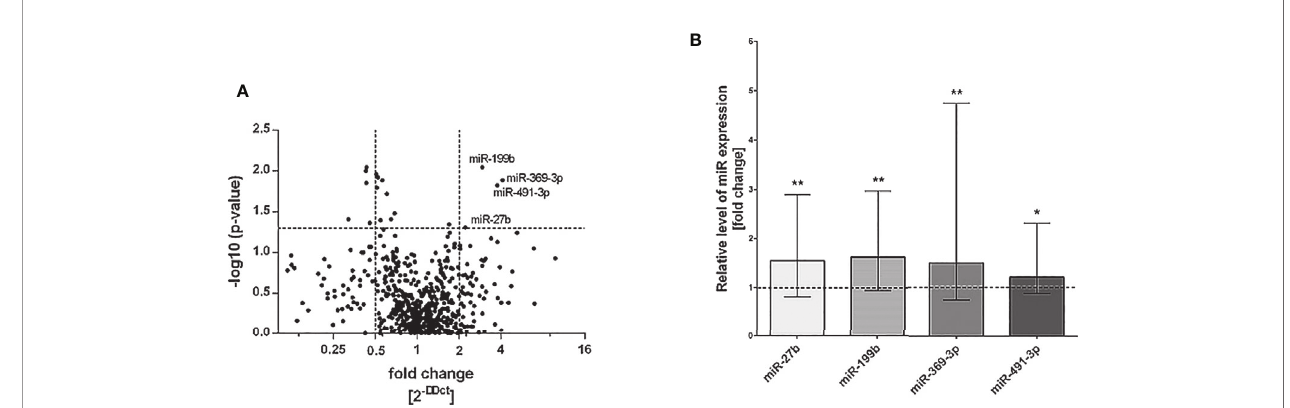
FIGURE 1 | miRNA real-time PCR analysis. Volcano plot showing differential miRNA expression levels in patients with HSV infection in comparison to control group. The vertical lines correspond to 2-fold up and down change and the horizontal line represents a P value of 0,05 (A) . Expression of miRNAs miR-27b, miR-199b, miR-369-3p and miR-491-3p presented as fold change of each miR relative expression normalized to U6 expression and healthy control group (2 − DD CT ). The results were obtained from individual real-time PCR reactions performed in all patients and control subjects. Dashed line signi fi es the control group. Data was analyzed using non-parametric Kruskal-Wallis test with Dunn ’ s post-hoc test. Asterisks mark signi fi cant differences: *p<0,05, **p<0,01 (B) .